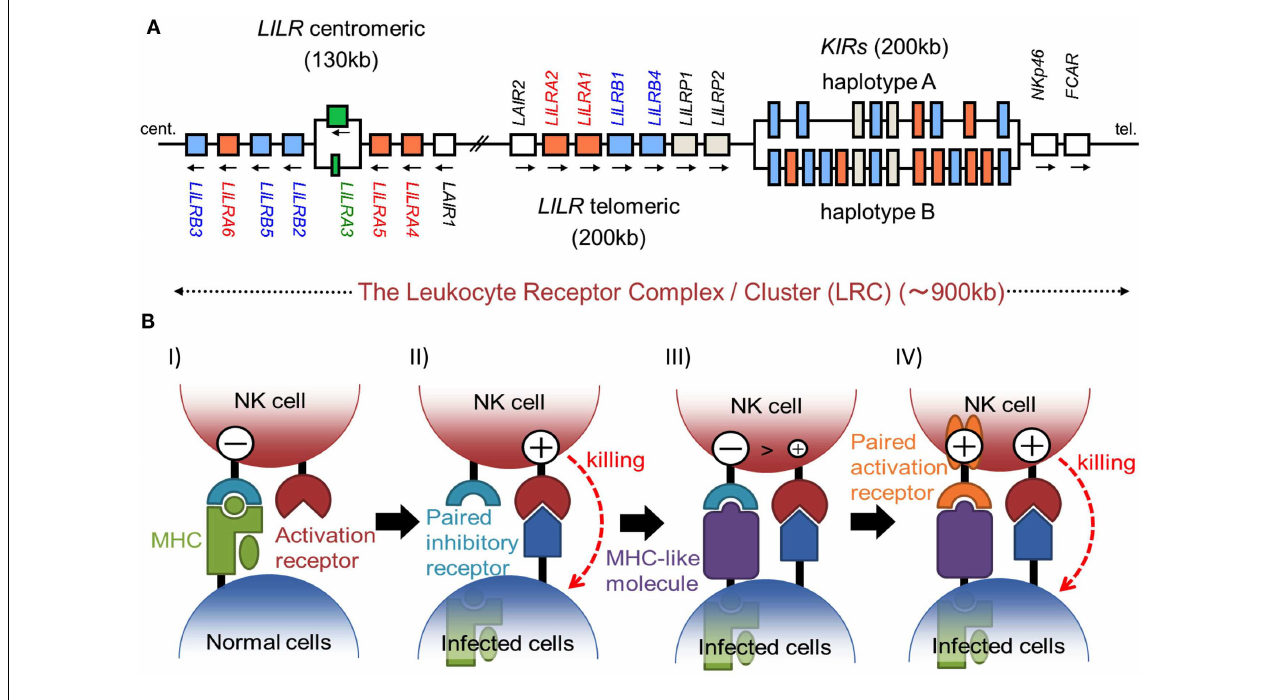
inhibitory signals through it protect the normal self-cells from NK cell killing. II) In the infected cells, the low level expression of MHCIs induces the NK killing, in a system called the “missing-self hypothesis.” III) In order to escape the host NK cytotoxicity, some viruses acquired the expression of MHCI-like molecules (purple), which bind to the inhibitory receptors. IV) On the other hand, NK cells express activation receptors (orange), which evolved from the related inhibitory receptors to trigger NK cell activation.